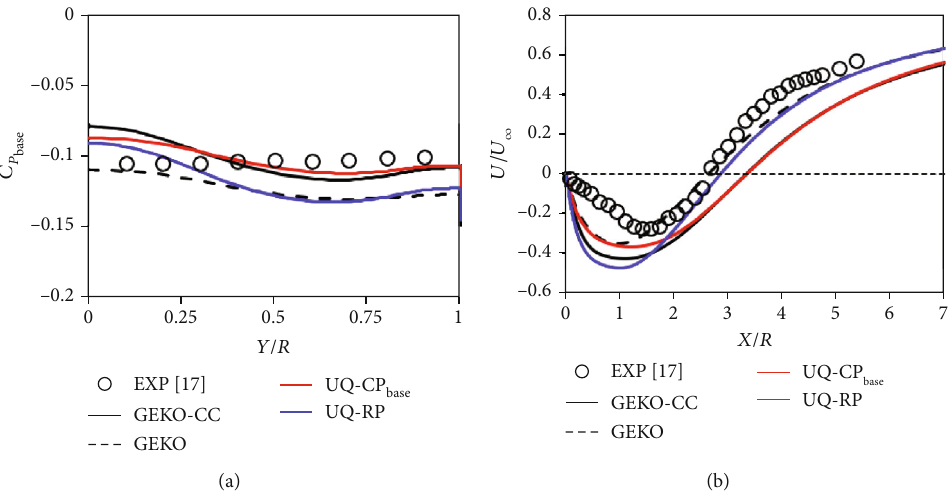
0–0.2–0.15–0.1–0.050 Figure 18: Pressure distribution (a) and centerline velocity (b) with correlated coe ffi Figure 19: Nondimensional pressure (a) and skin friction coe ffi cient (b) distribution with correlated coe ffi cients.